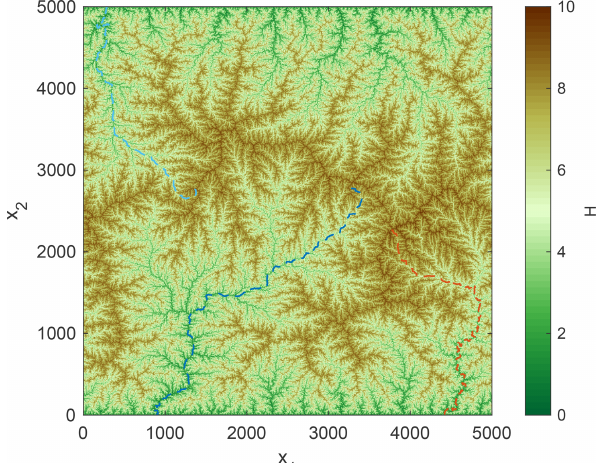
Figure 9. Topography obtained under the same conditions as in Fig. 7 but assuming that erosion by meltwater follows the same re- lation as fluvial erosion with the same